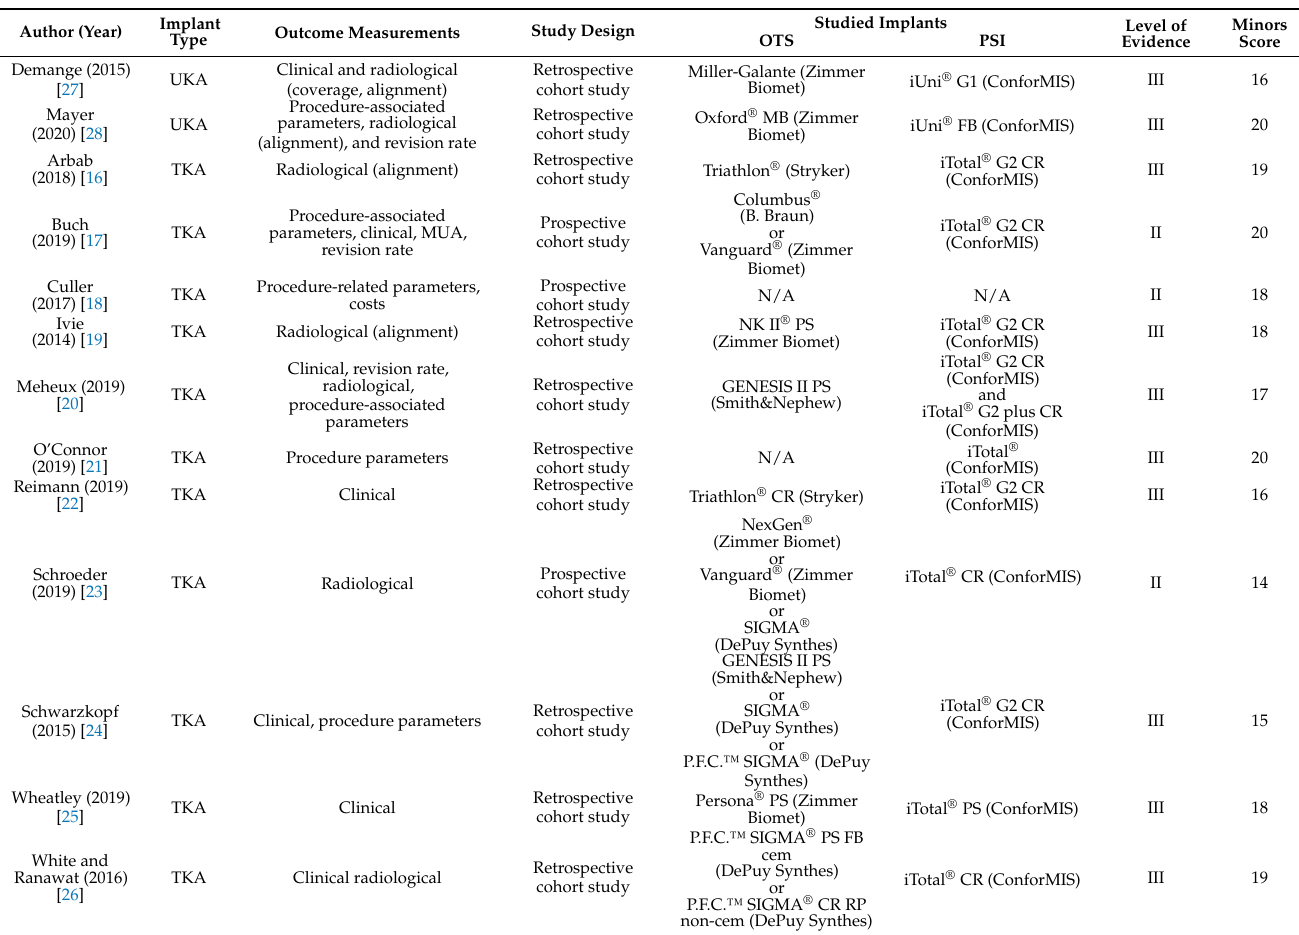
Table 1. Overview selected